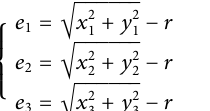
FIGURE 3 Schematic diagram of horizontal section